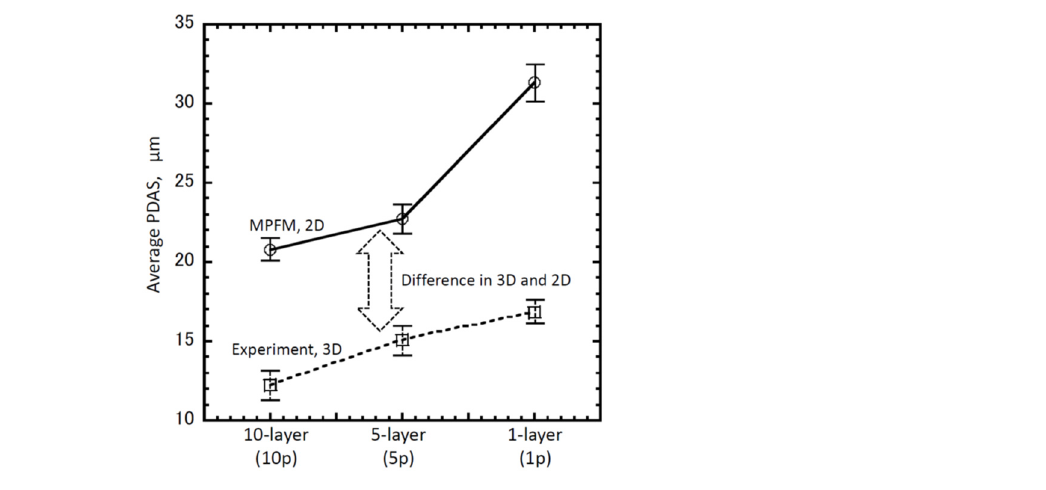
Figure 10. Schematic illustration of the quasi-equilibrium, parallel tangent law of the solute element between α and β phases.